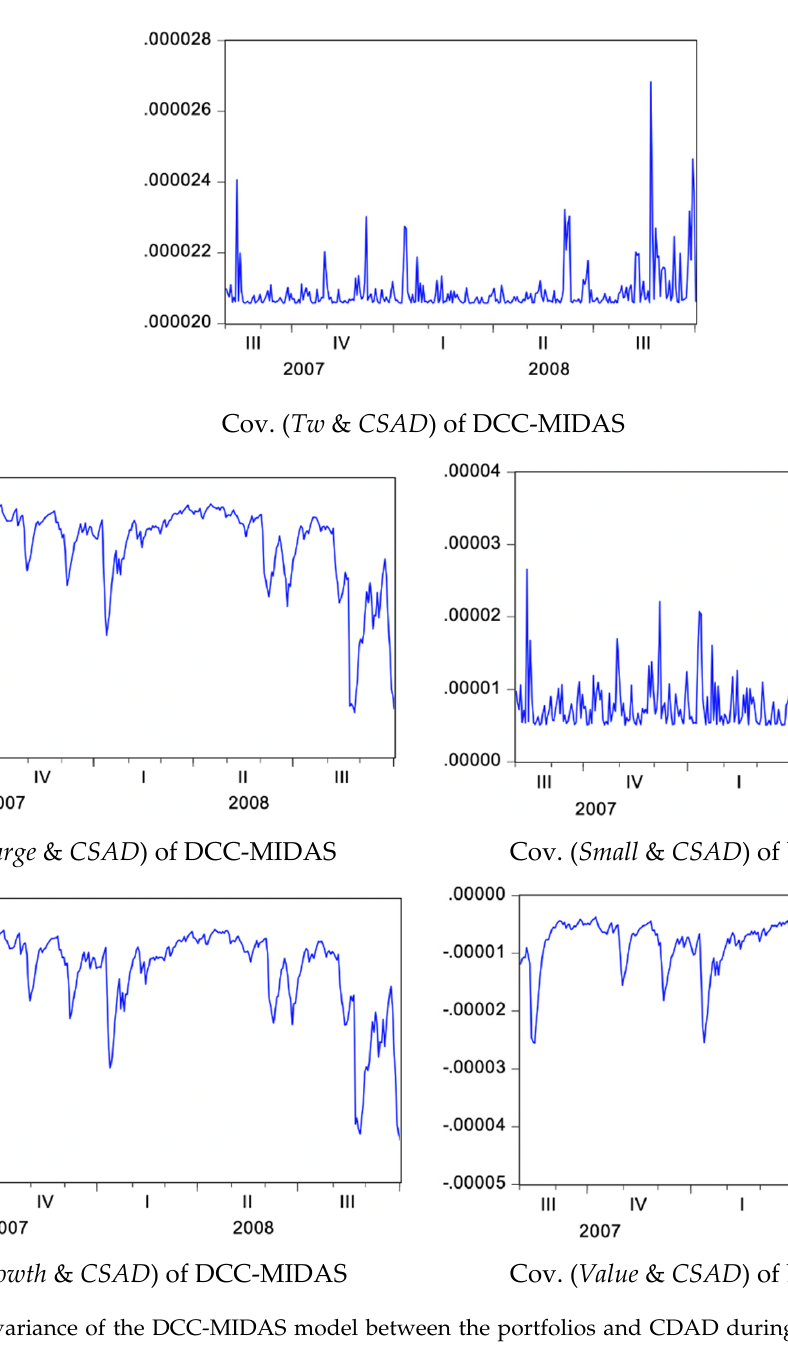
Figure 2. The covariance of the DCC-MIDAS model between the portfolios and CDAD during the subprime periods (2007–2008).